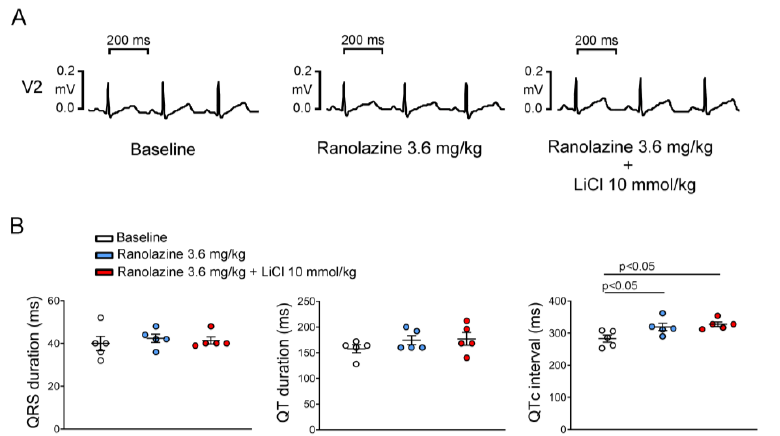
Figure 7. Effects of ranolazine on electrocardiography parameters in lithium chloride (LiCl)-treated male rabbits. Representative electrocardiography tracings ( A ) and average data ( B ) of the QRS duration, QT interval, and corrected QT (QTc) interval from male rabbits ( n = 5) treated with LiCl (10 mmol/kg) with ranolazine pretreatment.